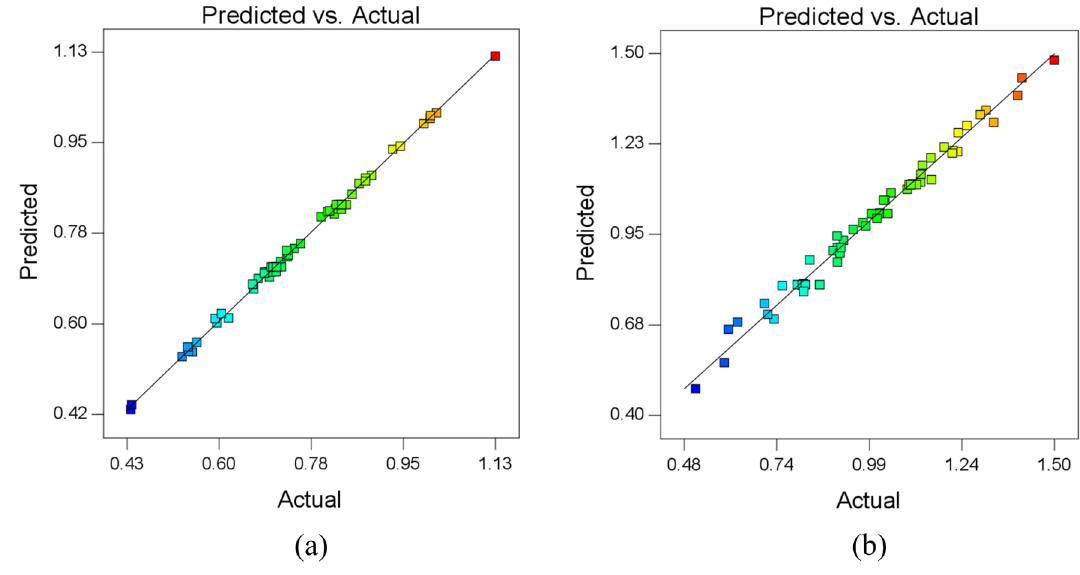
Figure 8. Predicted vs actual ( a ) MR and ( b ) R a R a = 7.135 − 0.00122 × Tool Rotation + 71.014 × Feed Rate − 0.06371 × Ultrasonic Power − 0.02914 × Diamond Abrasive Grit Size + 0.00001735 × Tool Rotation × Ultrasonic Power − 1.608 × Feed Rate × Ultrasonic Power + 0.717 × Feed Rate × Diamond Abrasive Grit Size + 0.0000715 × Diamond Abrasive Grit Size 2 .